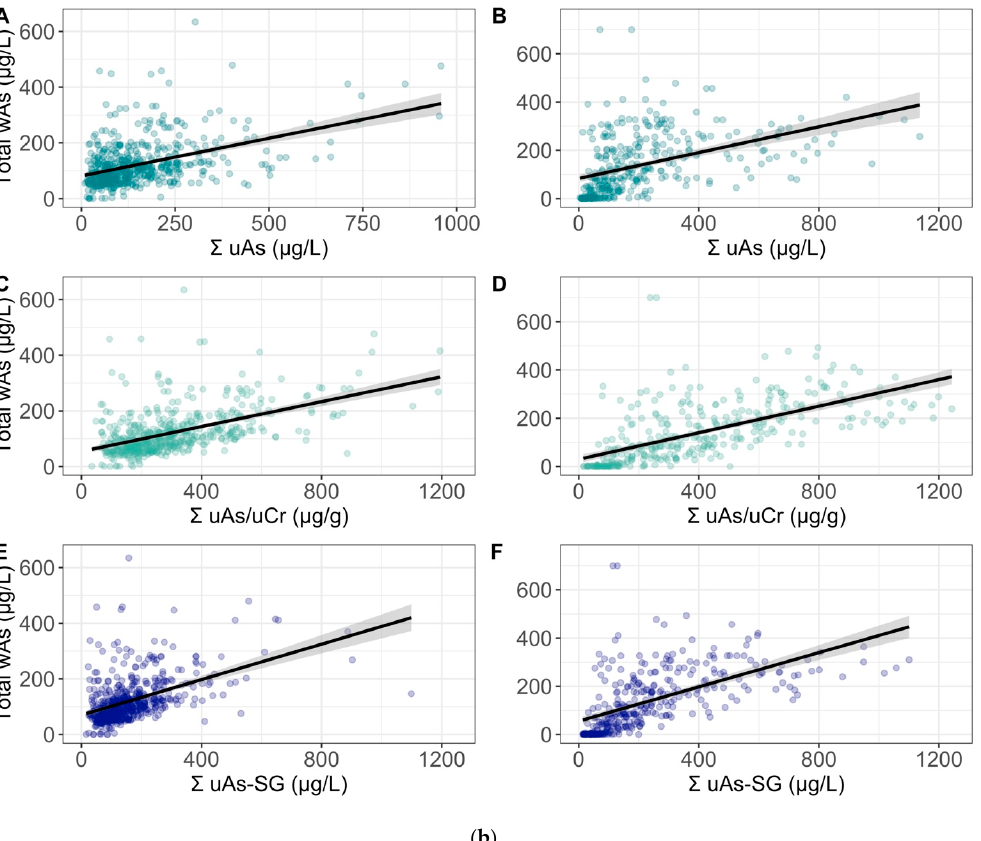
Figure 2. ( a ) Crude Log–Log linear models of the sum of blood arsenic species ( Σ bAs) with the sum of urinary arsenic species ( Σ uAs) that is unadjusted, adjusted for creatinine (uCr) and adjusted for specific gravity (SG) in FACT (A,C,E) and FOX (B,D,F), respectively. ( b ) Crude Log–Log linear models of total water arsenic (wAs) with the sum of urinary arsenic species ( Σ uAs) that is unadjusted, adjusted for creatinine (uCr) and adjusted for specific gravity (SG) in FACT (A,C,E) and FOX (B,D,F), respectively.